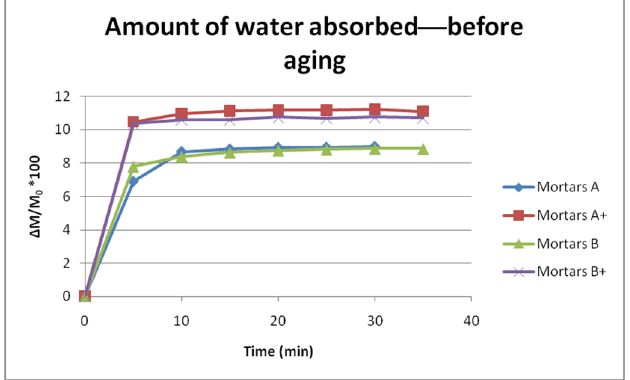
Figure 1. Water absorbed for the designed mortars before aging.